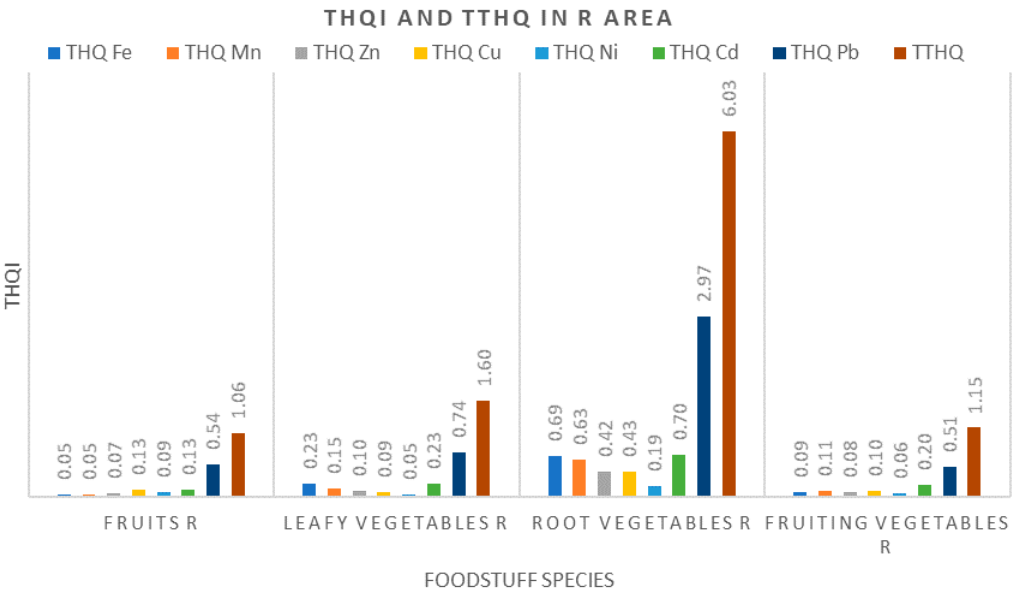
Figure 4. Measured values for individual health risks of metals analyzed (THQi) and total target hazard quotients (TTHQ in the Rusca Montana (R) area .